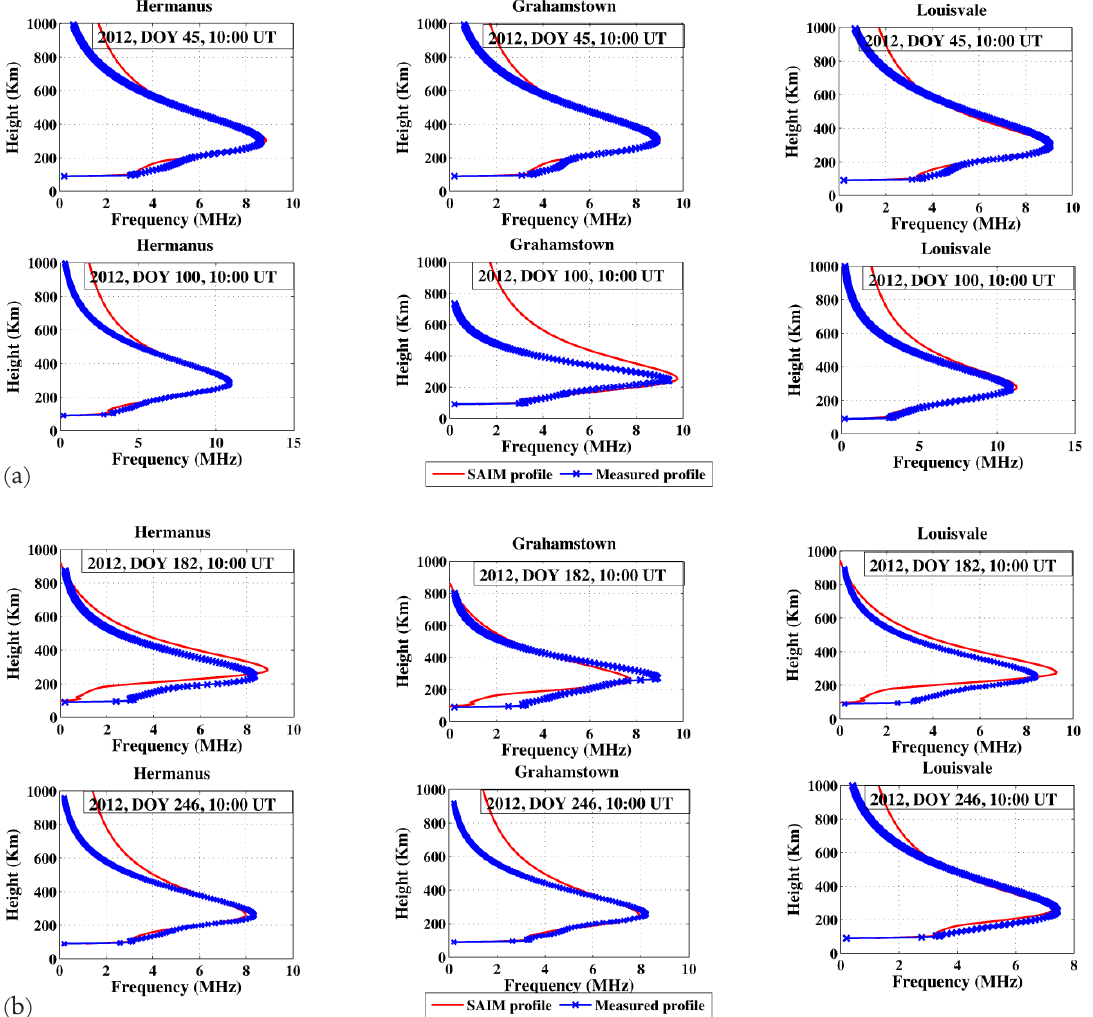
Figure 10. A comparison of SAIM profiles and ionosonde profiles from three stations: Hermanus, Grahamstown and Louisvale, for (a) sum- mer (DOY 45) and autumn (DOY 100) in 2012, and (b) winter (DOY 182) and spring (DOY 246) in